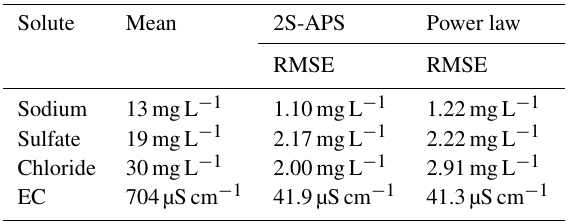
Table 6. Summary of values of RMSE criterion calculated for the three ions and EC.